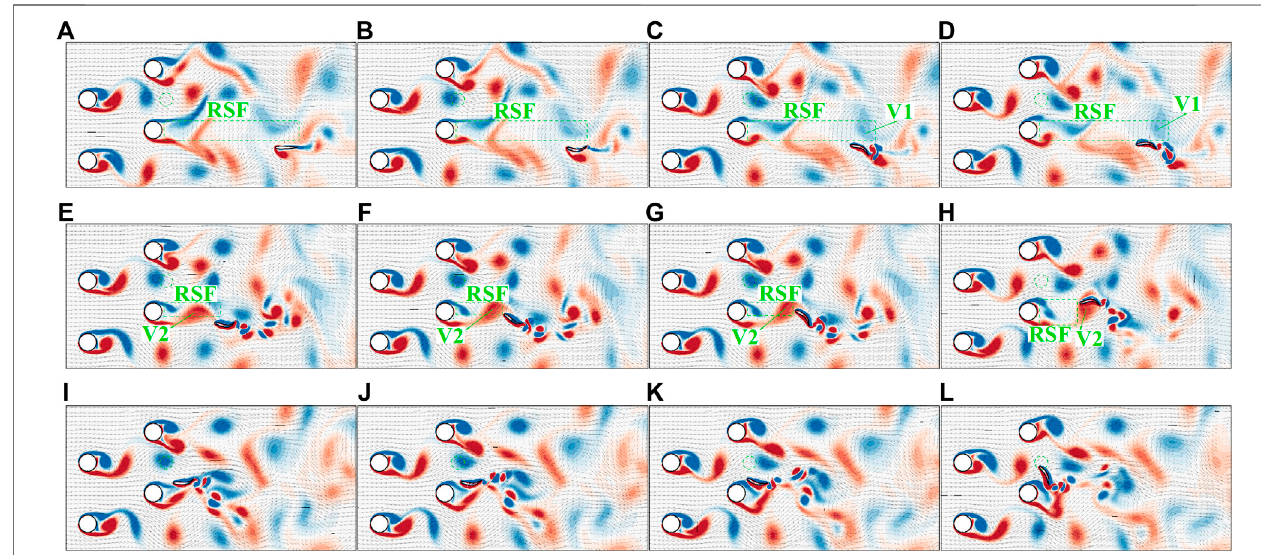
FIGURE9| Vorticitycontourand fl owvelocitydistributionat12differentinstants: (A) t / T =50, (B) t / T =51.5, (C) t / T =53, (D) t / T =54, (E) t / T =61.5, (F) t / T =62.5, (G) t / T = 63, (H) t / T = 65, (I) t / T = 72.5, (J) t / T = 73.5, (K) t / T = 74.5 and (L) t / T = 75.9.